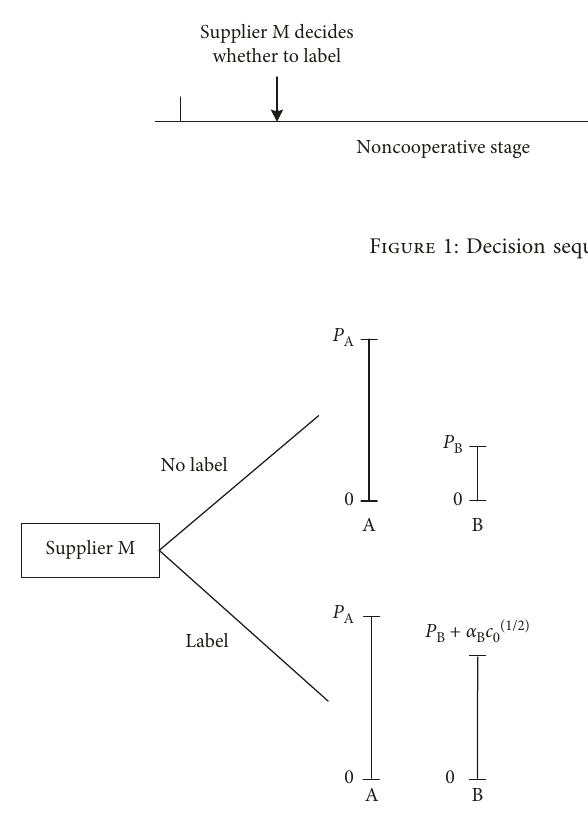
Figure 2: Prices of manufacturers’ product in BIGM.